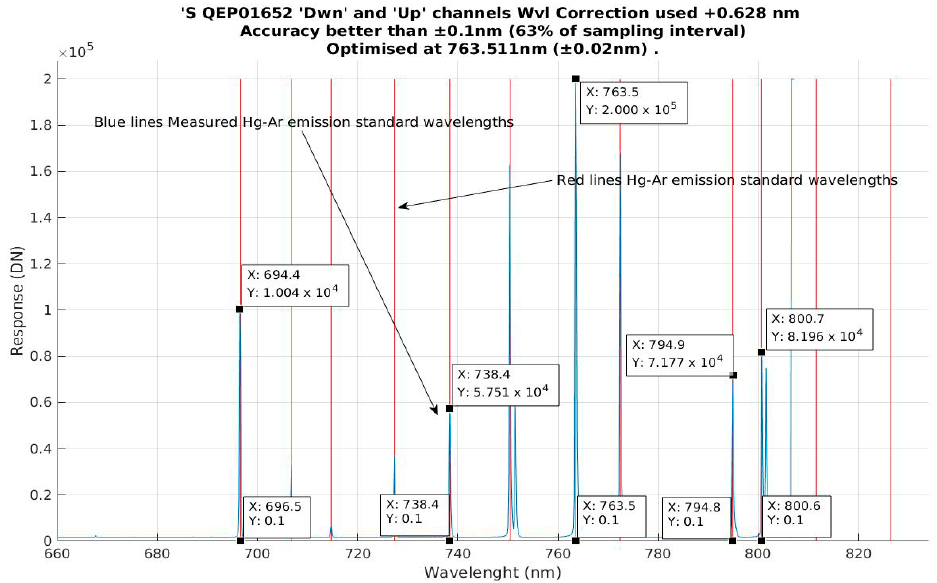
Figure 4. Report on Piccolo system calibration for QEPro 01652 as an example provided by Piccolo system suppliers.